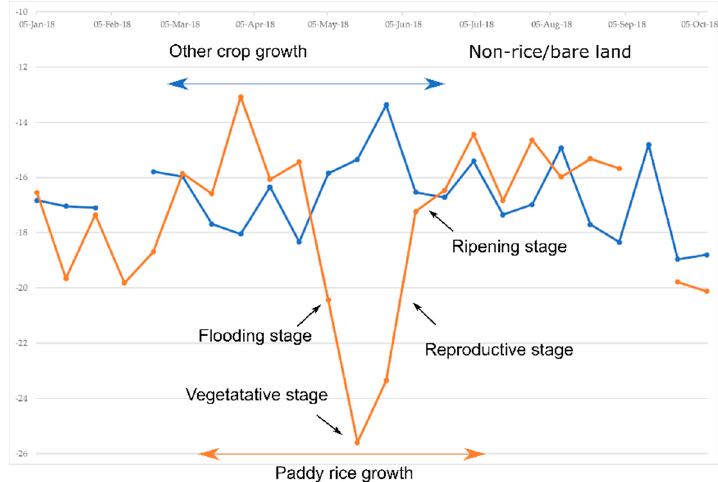
Figure 5. The example of rice detection workflow for each pixel with vertical-horizontal backscattering (VH) values. The blue line is the example of a non-rice cultivation class ( − 7° 10' 34.9",111° 52' 55.42"), and the orange line is the example of a rice cultivation class ( − 6° 27' 57.27",108° 8' 56.64").